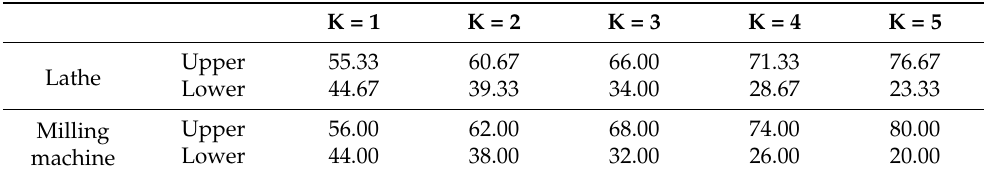
Figure 12. Power spectrum of the lathe ( left ) and the milling machine ( right ) tested.